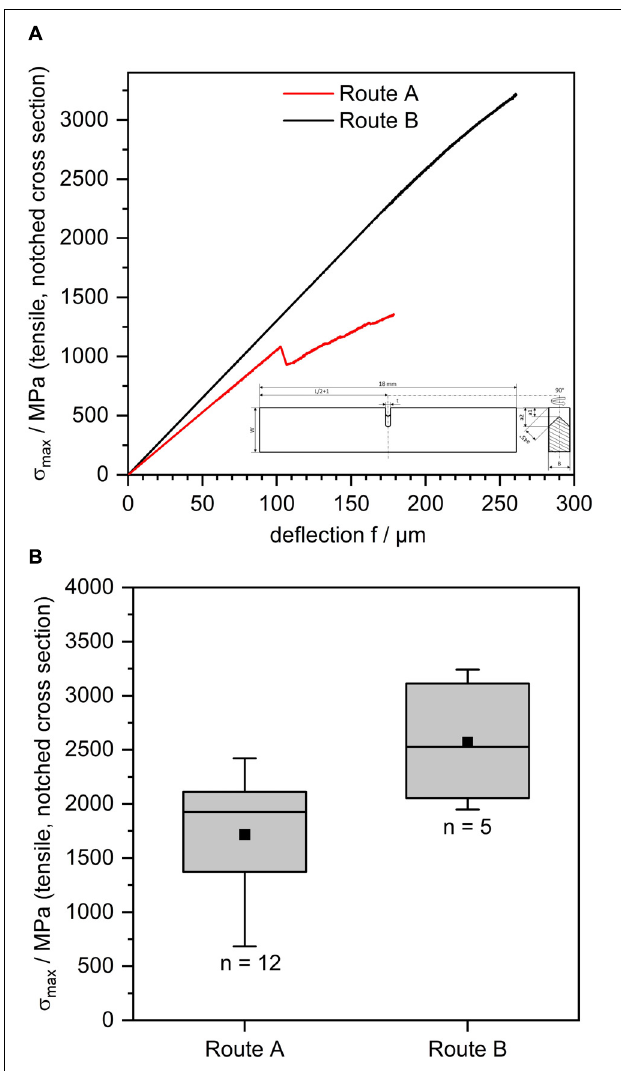
FIGURE 4 | Three-point-bending (3PB) tests of chevron-notched samples of routes A and B in air. (A) Stress deflection curves and (B) boxplots of the maximum bending stress on the remaining ligament at fracture ( n = number of tested samples).